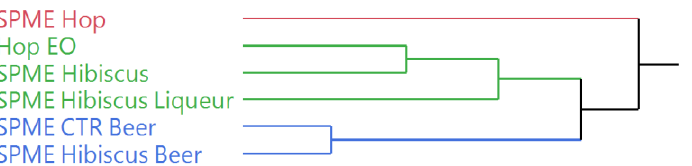
Figure 3. Dendrogram of the hierarchical cluster analysis (HCA) performed on the complete compo- sition of the Cascade hop EO and the headspaces of the plant materials and the beverages. The score and the loading plots of the principal component analysis (PCA) are re- ported in Figure 4.